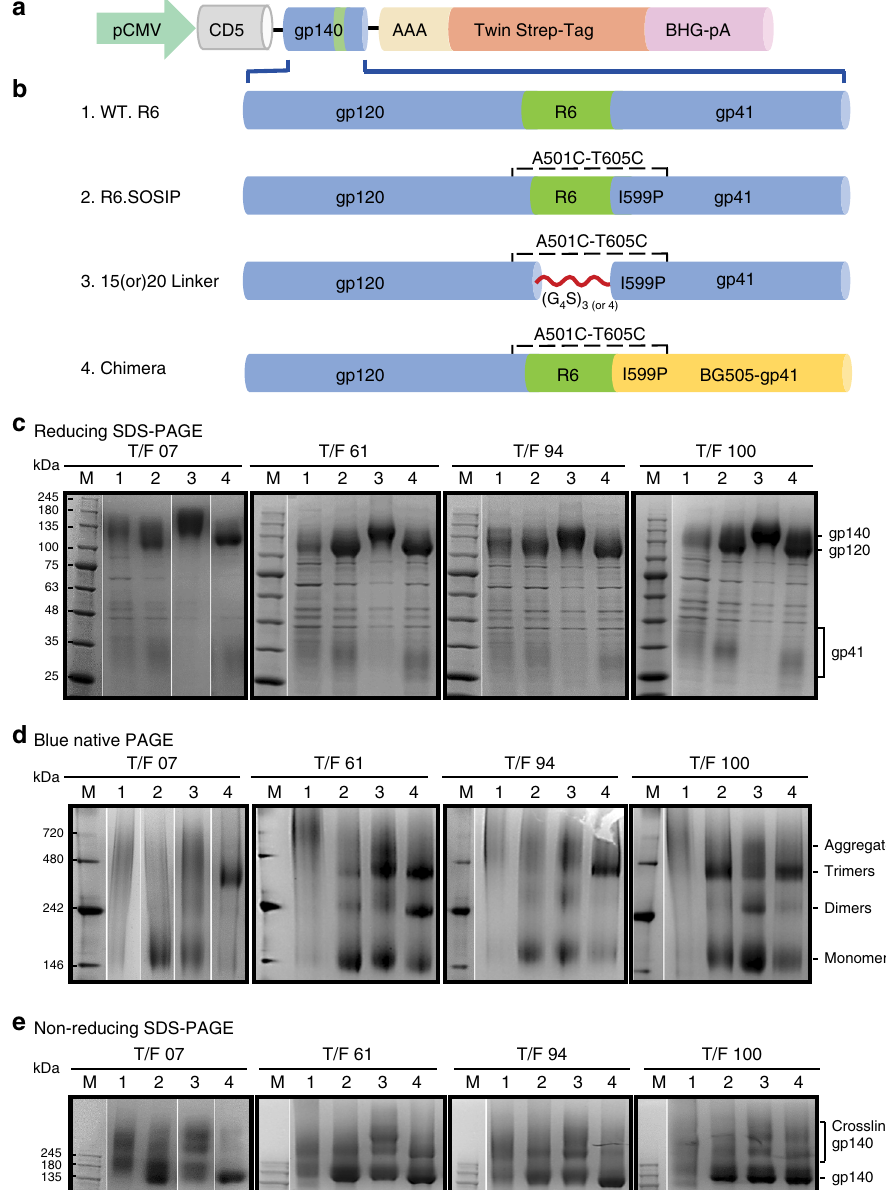
(R6) between gp120 and gp41. (2) R6. SOSIP, the three SOSIP mutations A501C, T605C, and I599P introduced into the WT.R6 clone. (3) 15 (or) 20 Linker, 15 (G 4 S) 3 or 20 (G 4 S) 4 amino acid linker introduced between gp120 and gp41 replacing the furin cleavage sequence. This construct also includes the